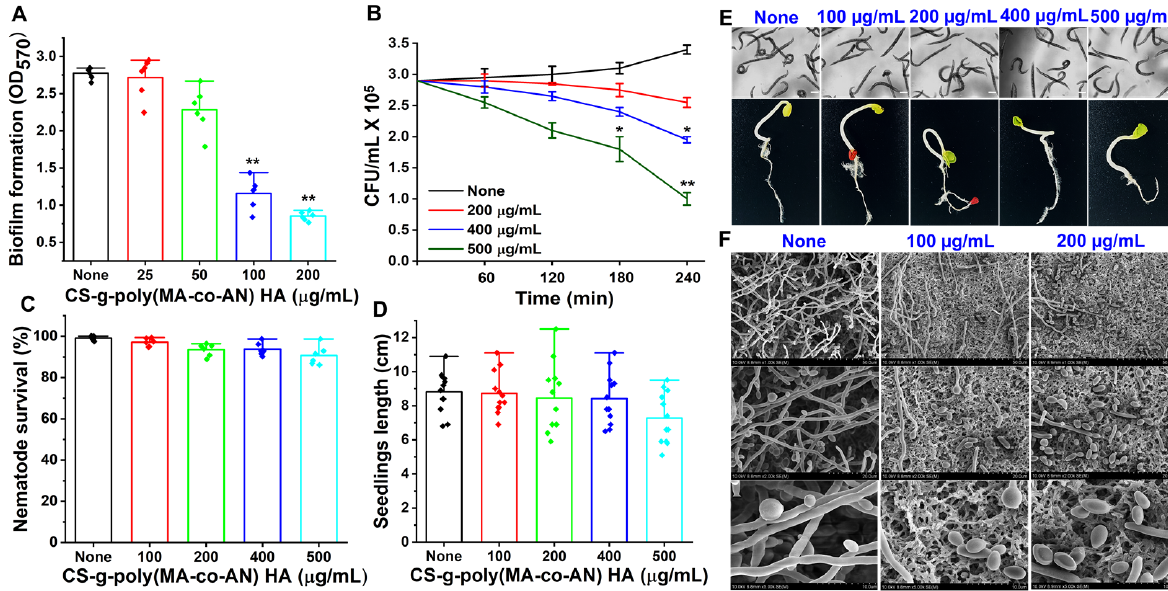
Figure 3. Appraisal of the antifungal and antibiofilm potency of CS-g-poly (MA-co-AN) HA complex against C. albicans DAY185. ( A ) Biofilm development of C. albicans DAY185 in the presence of CS-g-poly (MA-co-AN) HA. ( B ) Rapid killing of C. albicans by CS-g-poly (MA-co-AN) HA. After incubation of 24 h with CS-g-poly (MA-co-AN) HA, the cultures were plated and CFUs were counted. ( C ) Bar graph indicating the % of nematodes survivals that were treated by CS-g-poly (MA-Co-AN) HA polymer composite for seven days. ( D ) Bar graph demonstrating the effects of CS-g-poly (MA-co-AN) HA polymer composite on seedlings length after seven days. ( E ) Effects of CS-g-poly (MA-co-AN) HA polymer composite on C. elegans and seed germination of R. raphanistrum . Scale bar =100 µm. ( F ) SEM observation of C. albicans biofilms. The results are described as means ± SDs of triplicate. The error bars show the standard deviations. ** p < 0.01 and * p < 0.05 vs.